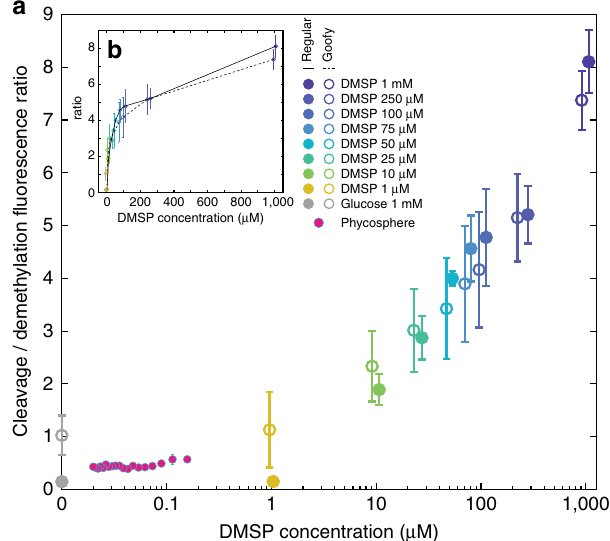
Fig. 3 DMSP concentration modulates relative expression of dddW and dmdA . a Cleavage-to-demethylation pathway ratio was calculated at each DMSP concentration for strains Regular (RFP/TFP) and Goofy (TFP/RFP). High variability of fl uorescence output amongst replicate experiments at ≥ 10 μ M DMSP prevented the comparison of pathway reporters within each color (Supplementary Fig. 5). Average fl uorescence signals at time points at which dmdA expression is mid-exponential for each DMSP concentration (shown in Supplementary Fig. 6), or at the second time point for glucose and 1 μ M DMSP conditions, were used for ratio calculation. Close